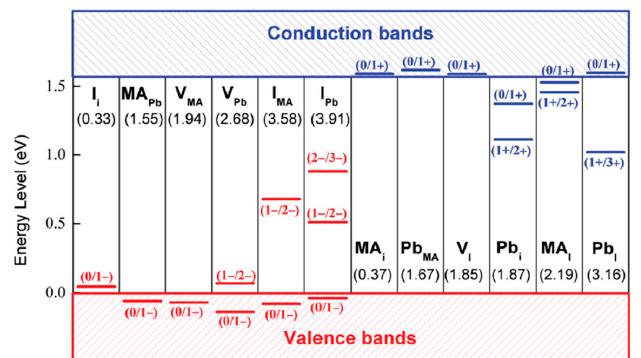
Figure 7. Calculated transition energy levels of various types of point defects in MAPbI 3 (interstitials (i), ion substitutions and vacancies (V) are indicated). The formation energies of neutral defects are shown in parentheses. The acceptors (red, trapping electrons) and donors (blue, trapping holes) are ordered by the formation energies (from left to right). Reproduced with permission from Adv. Mater. 2014 , 26 , 4653–4658 . Reference [17].